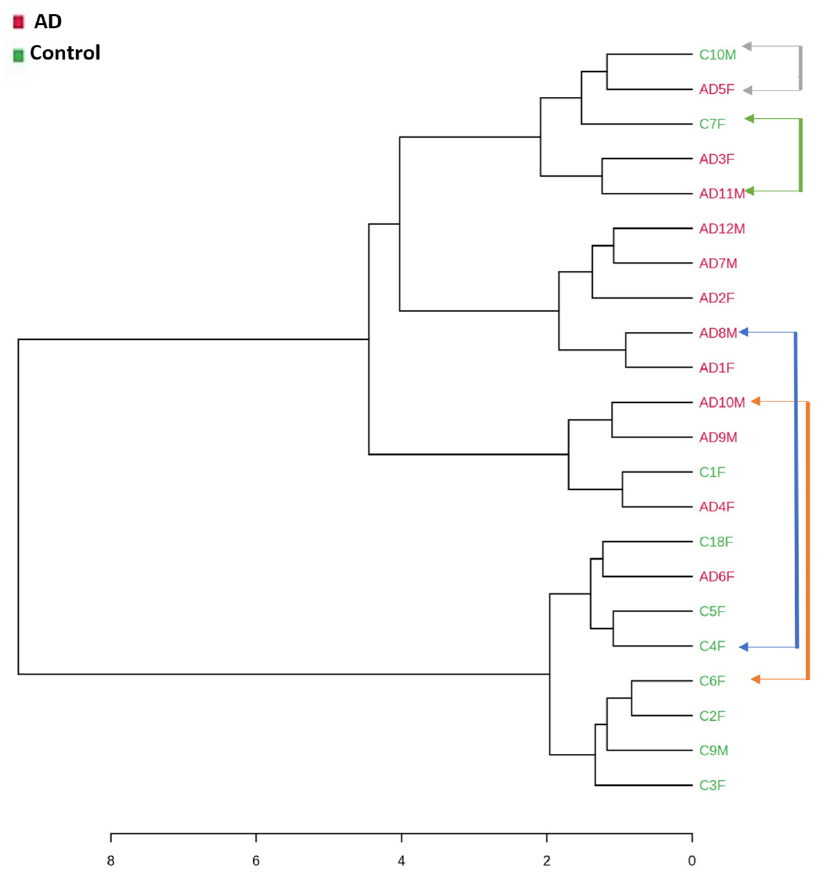
Figure 6. Dendrogram with a Spearman distance measure and a Ward clustering algorithm obtained from the total of VOCs identified in the feces from the control subjects and the Alzheimer’s disease (AD) patients. The pairs of the samples highlighted with an arrow correspond to the married couples; (n = 10, control subjects; n = 12, AD patients).